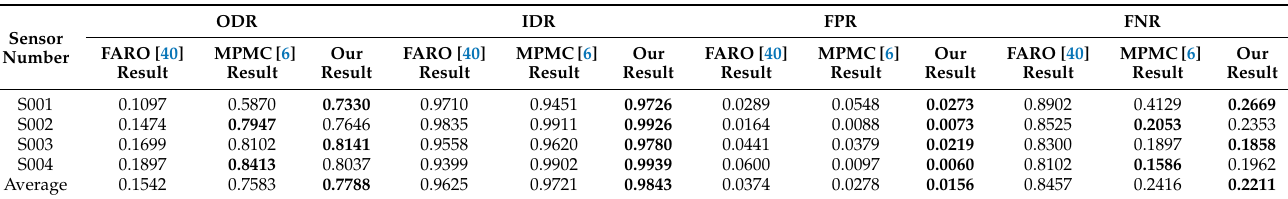
Table 7. Comparison of the quantitative performance.